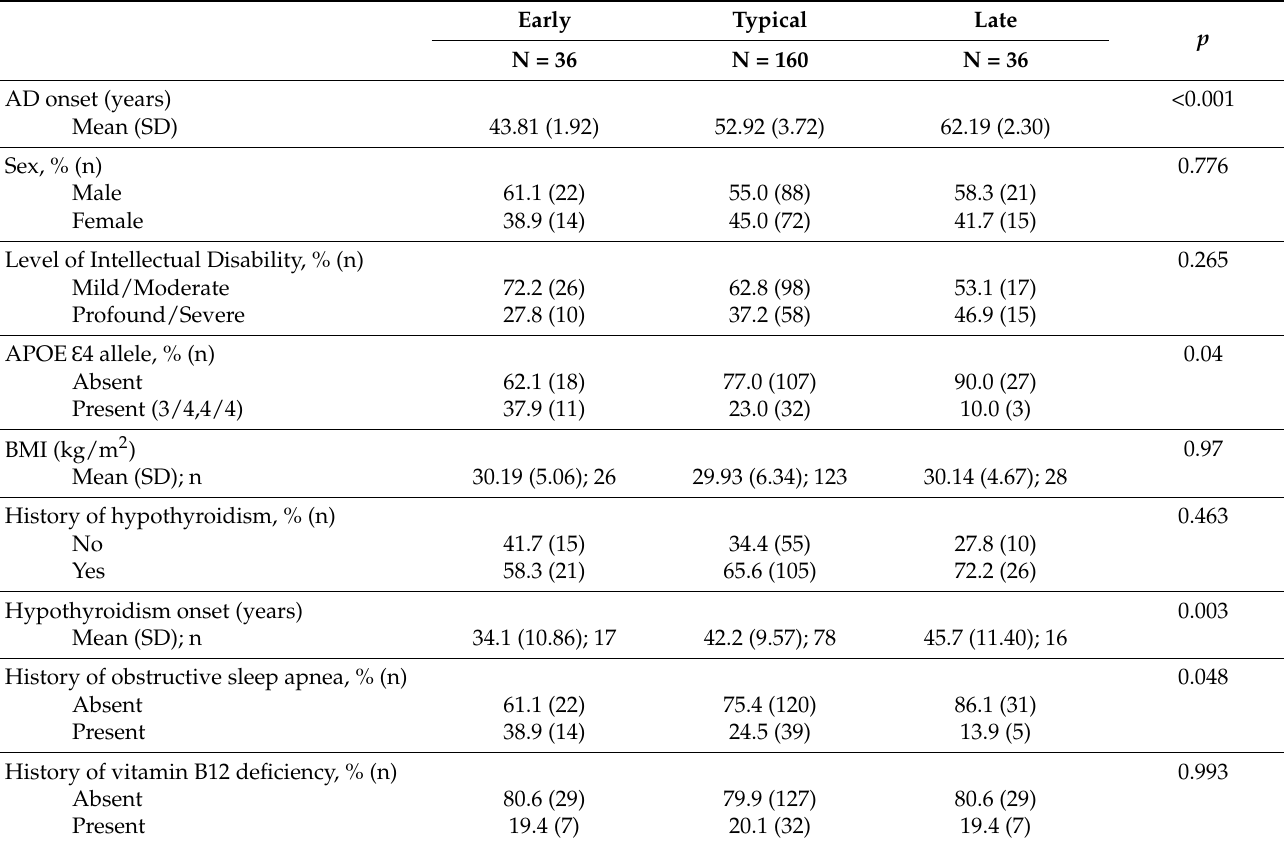
Table 1. Demographic summaries by age of AD onset group.